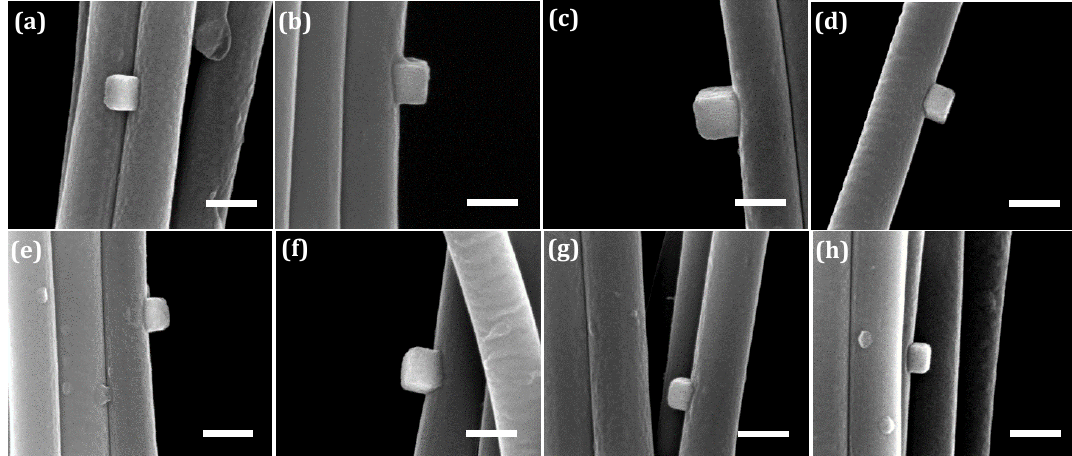
Figure 11. ( a – h ) Cubic copper nanostructures exhibiting different levels of substrate-influenced truncation on the nanofibers. Scale bar is 300 nm.